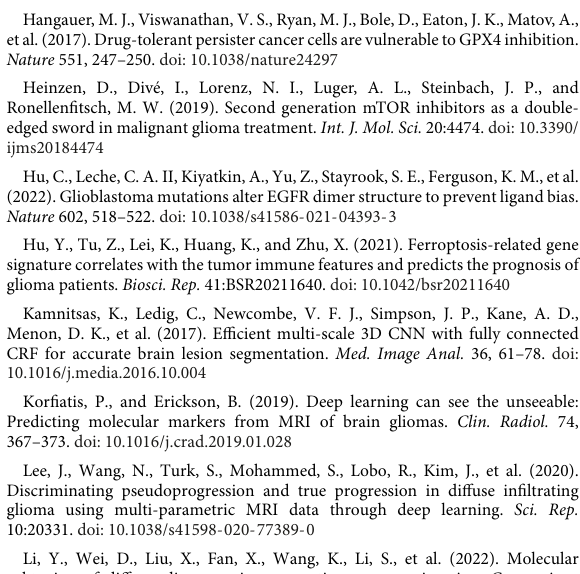
SUPPLEMENTARYFIGURE2 Venn diagram shows overlaps between genes conducted by univariate Cox regression analysis and DEGs. SUPPLEMENTARYFIGURE3 Based on the surv_cutpoint function in the survminer R package, the cut-off value of risk-score was determined to be − 0.1. SUPPLEMENTARYFIGURE4 Distribution of risk-score (top) ; survival time (bottom) . SUPPLEMENTARYFIGURE5 Summary ROC curves for the network (TC-mask and WT